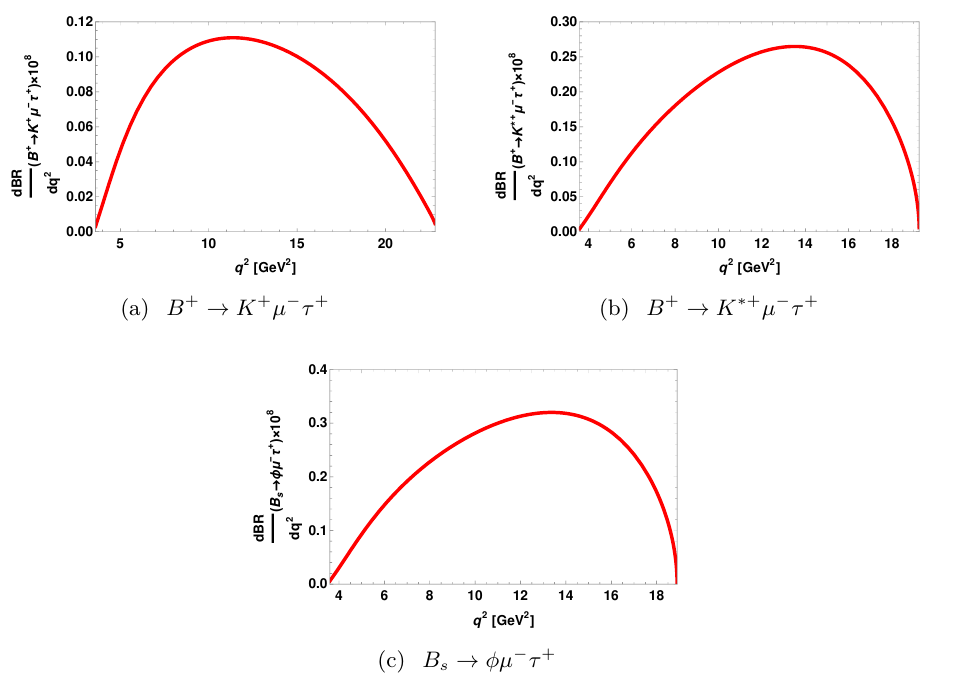
Figure 7 . Behaviour of the differential branching fractions of the LFV processes (a) B + → K + µ − τ + , (b) B + → K ∗ + µ − τ + and (c) B − τ + with respect to q 2 due to the effect of R 3 / 2 s → φµ